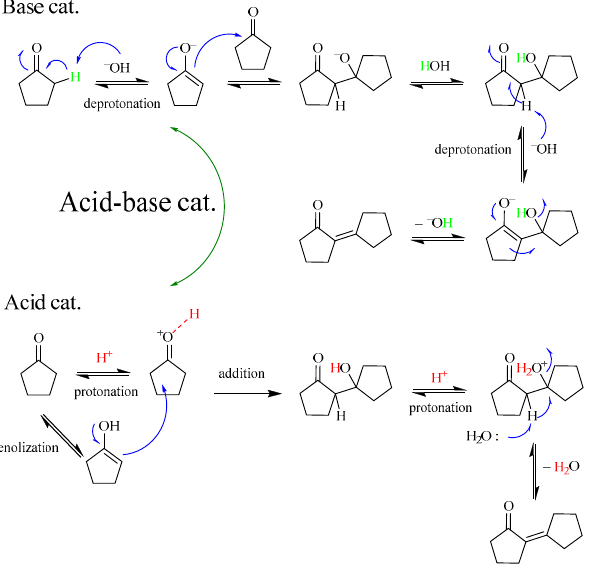
Figure 6. Reaction routes of cyclopentanone condensation reaction on the acid–base bifunctional catalyst. (OH − presented catalytic base site on SO 3 H-APG). catalyst. (OH − presented catalytic base site on SO 3